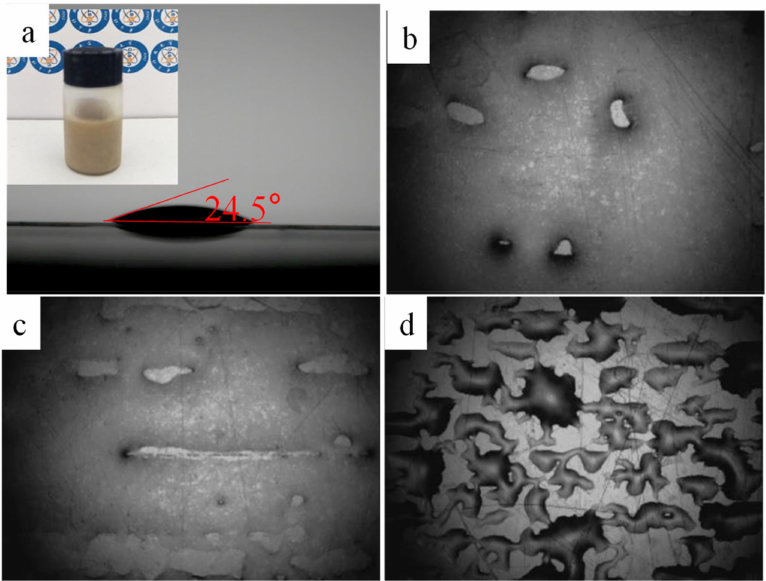
Figure 1. Contact angle image of ink droplet ( a ) and photographs of the ink on the PET surface after printing a layer (taken by the ink-et printer’s built-in camera) with nozzle spacing of 10 µ m ( b ), 15 µ m ( c ), and 20 µ m ( d